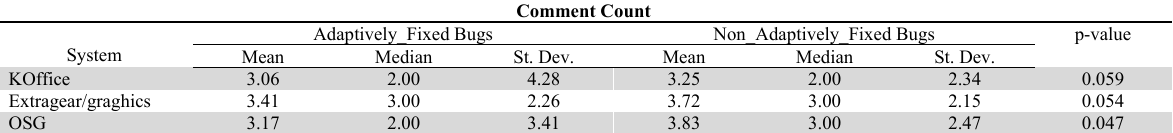
Comment Count In Adaptively_Fixed And Non_Adaptively_Fixed Bugs: Descriptive Statistics And Mann-Whitney Test (P-Value)